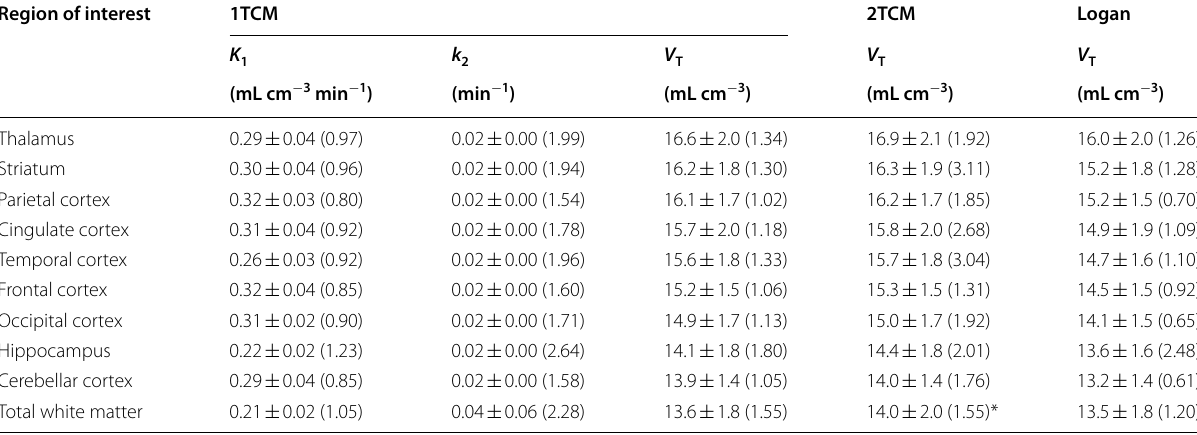
) values estimated with the one-tissue compartment model (1TCM), T